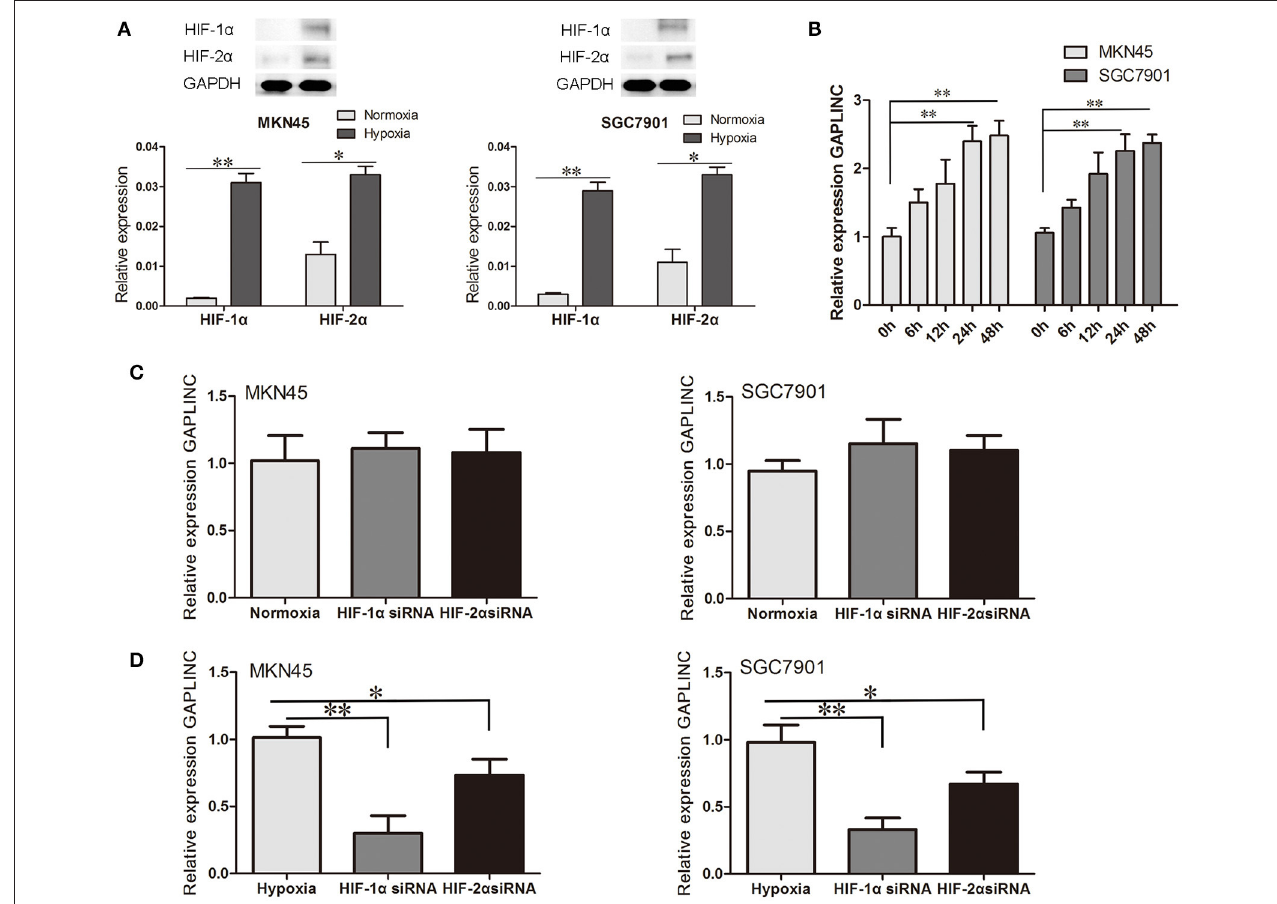
FIGURE 2 | GAPLINC expression was induced under hypoxia mainly by HIF-1 α . Data represent the mean ± SD. (A) HIF-1 α and HIF-2 α were upregulated in MKN45 and SGC7901 cells under hypoxic conditions. (B) GAPLINC was upregulated under hypoxia in MKN45 and SGC7901 cells. (C) qPCR analysis of